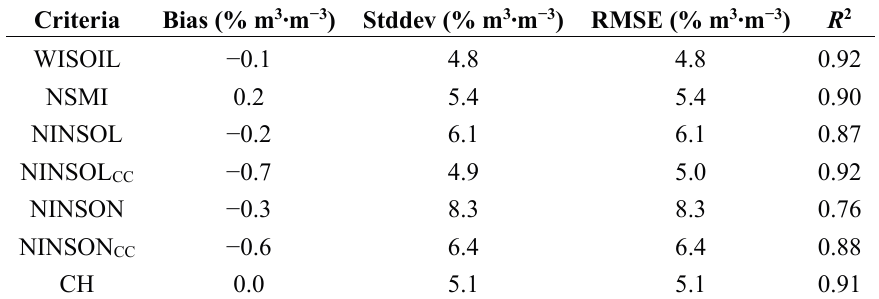
Table 3. Statistical performance from the validation of the models ( n = 232 spectra have been used during the validation